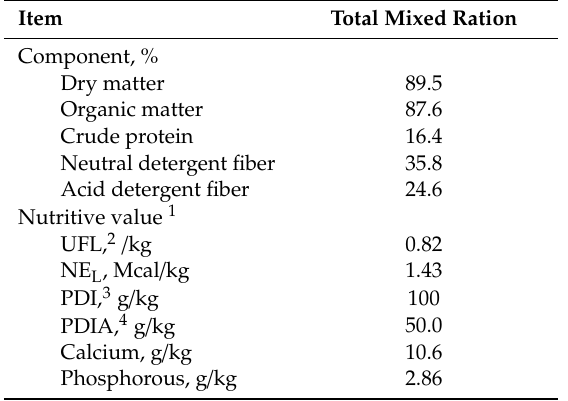
Table 1. Chemical composition and nutritive value of the control ration expressed on dry matter